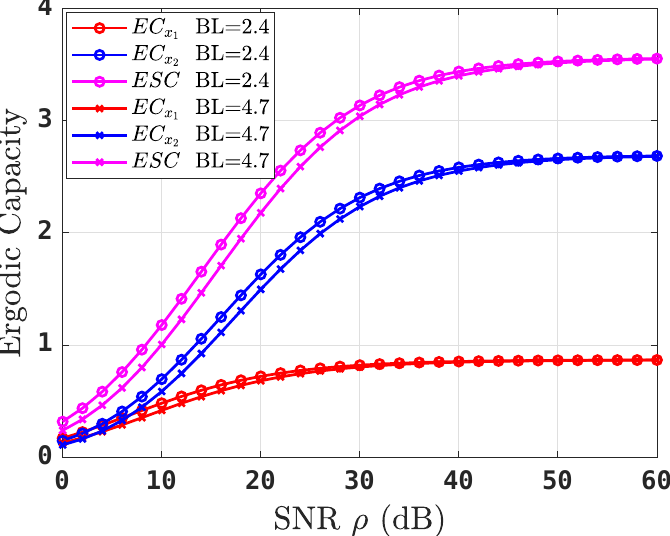
Figure 8. ECs versus SNR for thermally uniform UOWC links for varying air bubbles